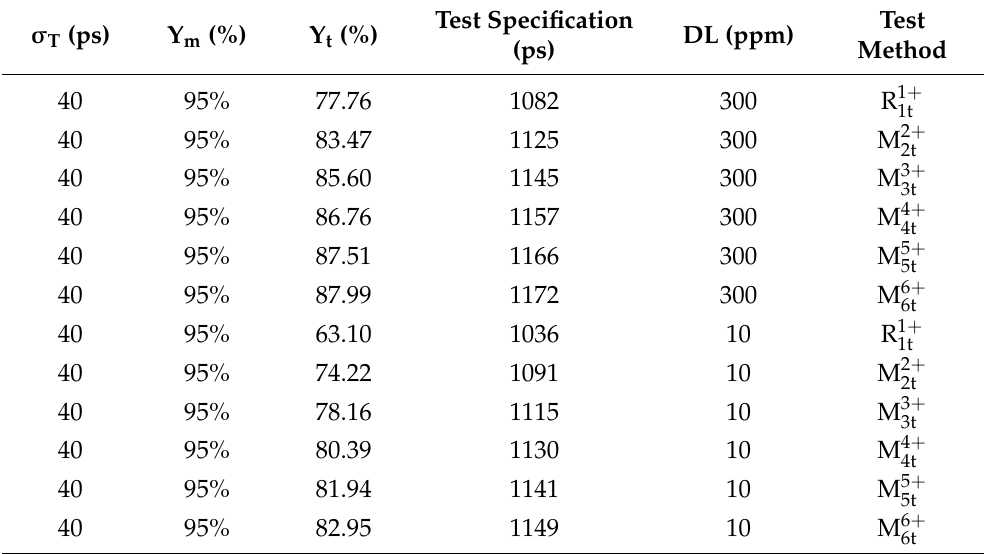
Table 3. Company profit surplus based on the number of